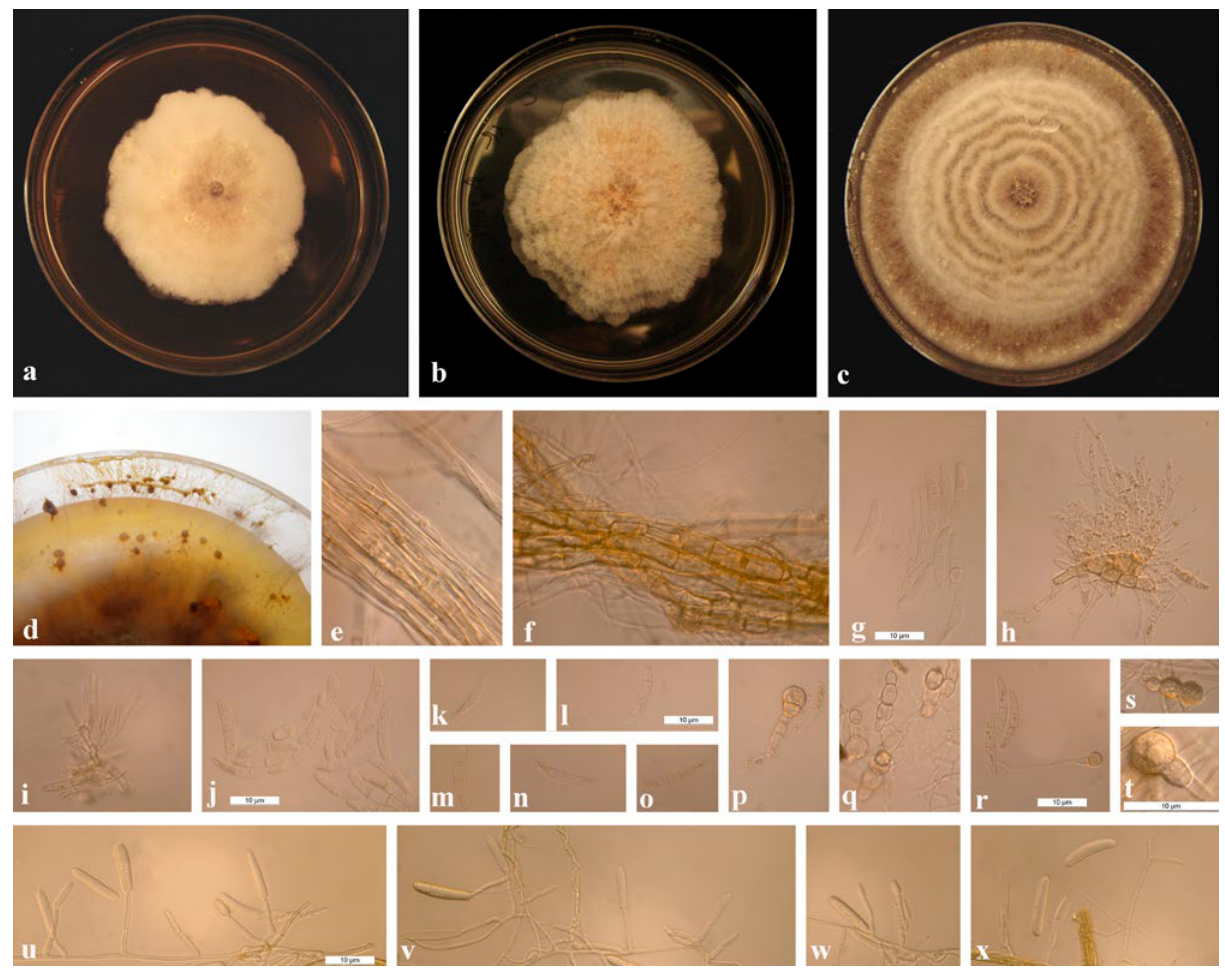
Figure 6. Thelonectria blackeriella sp. nov. (a-c) Sixteen-d-old colonies on MEA (a), PDA (b) and oatmeal agar (c), at 25°C. (d) Detail of exudates in Petri dishes containing conidia. (e, f) Mycelia in bundles of up to five. (g-i) Conidiophores and phialides. (j-o) Macroconidia most frequently observed in culture; (j), Different septate macroconidia; (k), 1-septate macro - conidia; (l), 2-septate macroconidia; (m), 3-septate macroconidia; (n), 4-septate macroconidia; (o), 5-septate macroconidia. (p-r) Chlamydospores formed by macroconidia. (s-t) Chlamydospores formed on hyphae. (u-x) Conidiophores and phialides in distilled